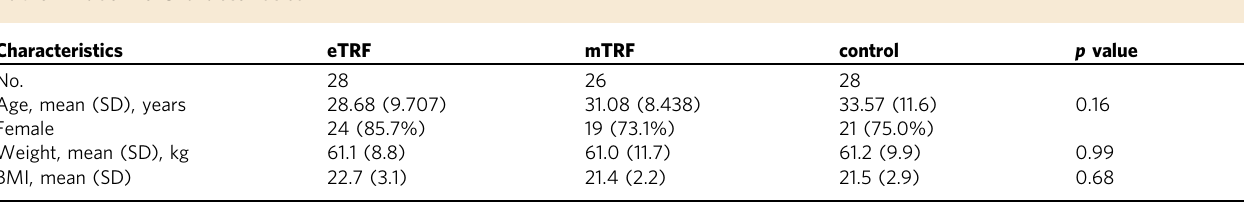
Fig. 1 CONSORT Flow Diagram. A total of 429 individuals were assessed for eligibility and 312 were excluded as they did not meet inclusion criteria, and 17 were excluded as they declined to participate. Ninety participants were randomized into one of three groups: eTRF, mTRF, or control, and baseline measures were assessed after randomization. During the 5-week intervention, eight participants (eTRF: n = 2; mTRF: n = 4; control: n = 2) dropped out due to dissatisfaction with the randomization result or for personal scheduling con fl icts. Remaining 82 participants completed the trial and were included in the present analysis. Table 1 Baseline